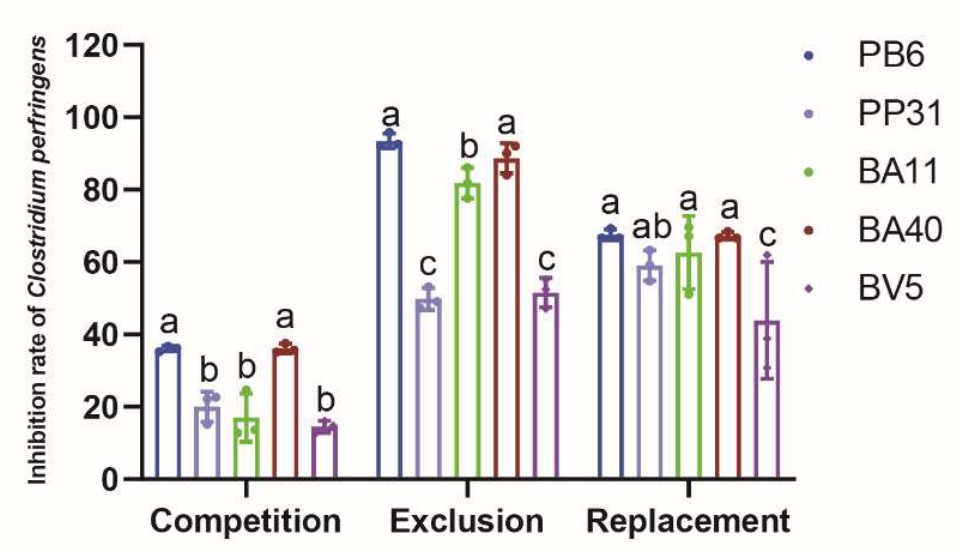
Figure 4. The inhibitory results of isolate strains on the adhesion of Clostridium perfringens . a, b, c